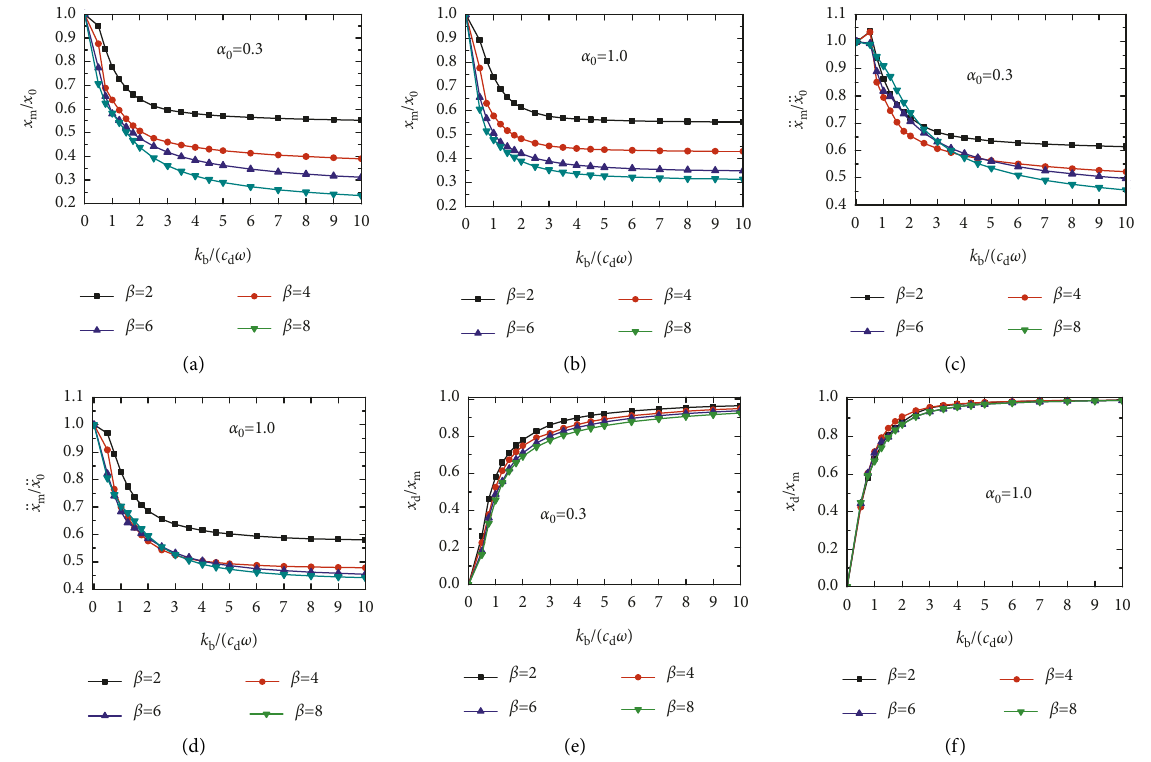
Figure 4: Influence of the parameter β on the seismic response of the SDOF structure ( T � 2 . 0s) with the exponent α (a)-(b) the displacement ratio of ETD to UST; (c)-(d) the acceleration ratio of ETD to UST; (e)-(f) the displacement ratio of VD to ETD.